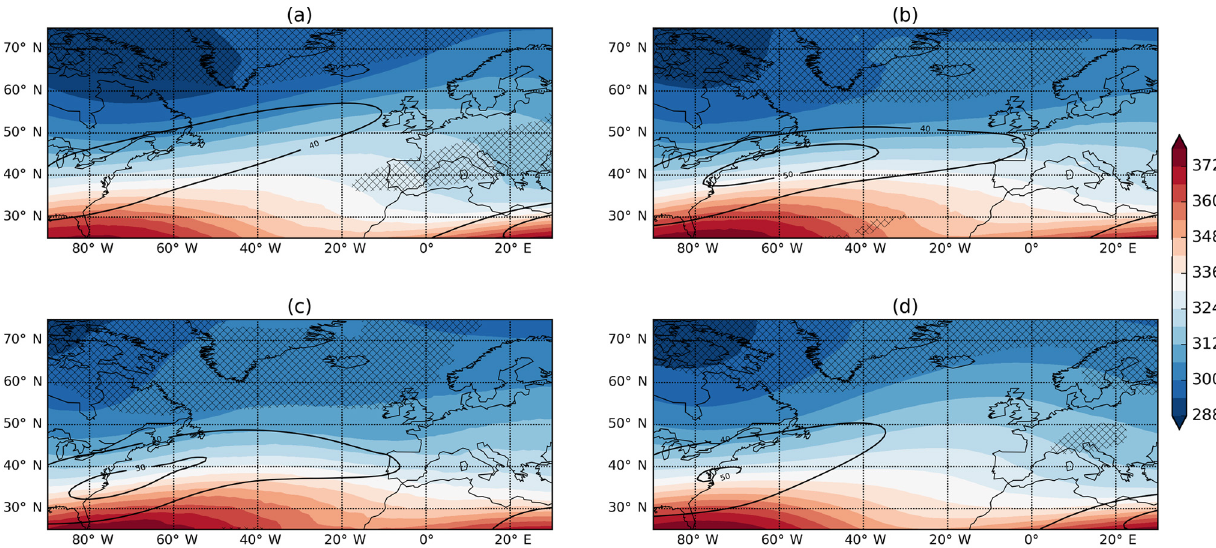
Figure 2. Dynamical composites of clustered days at (a) 65 ◦ N, (b) 55 ◦ N, and (c) 45 ◦ N. (d) Climatology. For all panels the coloured contours are θ on the 2 PVU surface (K). Black contours are the 250 hPa wind speed, starting at 40ms − 1 and increasing by 10ms − 1 . The crossed hatching is where RWB was occurring on at least 30% of